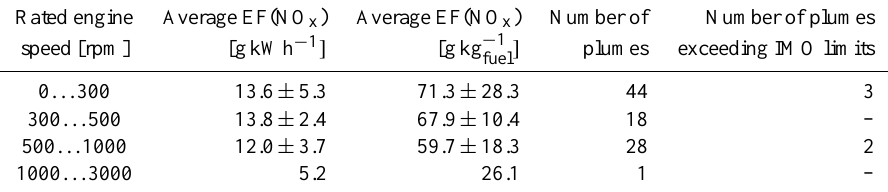
Table 3. NO x emissions in relation to the rated engine speed of the ships. In total 91 plumes were analyzed. In this table, ships running on 2-stroke engines are found below 300rpm. Ships with higher rated engine speeds were running with 4-stroke engines. In order to see if NO x emissions are exceeding the IMO limits, the measurement uncertainty was considered. It should be considered that in contrast to IMO regulation the measurements only show the instantaneous emission and not the total weighted emission of NO 2 following the technical code on control of emissions of nitrogen oxides from marine diesel engines (MEPC, 2008).